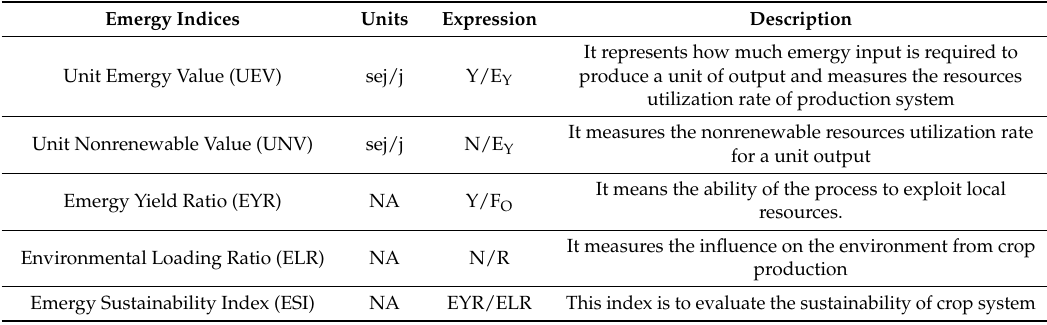
Table 3. Expression and description of emergy